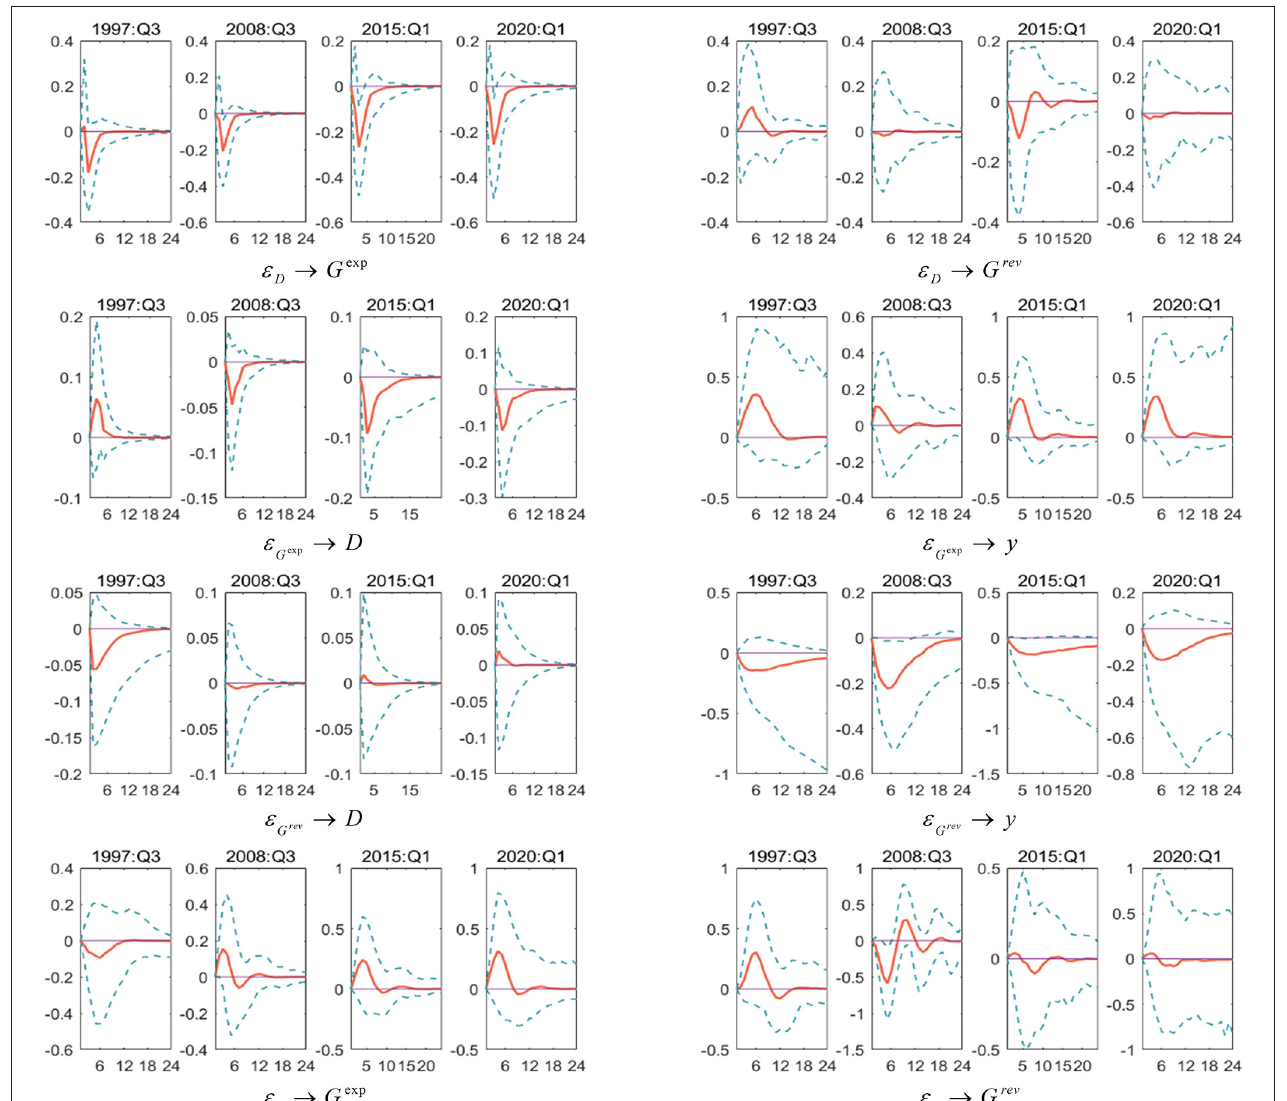
FIGURE 4 | Dynamic feedback trajectory of fiscal policy rules in particular period. Each subfigure with the title of “ X → Y ” demonstrates the response of variable Y to an orthogonalized positive shock of variable X. In other words, X is an impulse variable, and Y is a response variable. One period in the figure denotes one season.